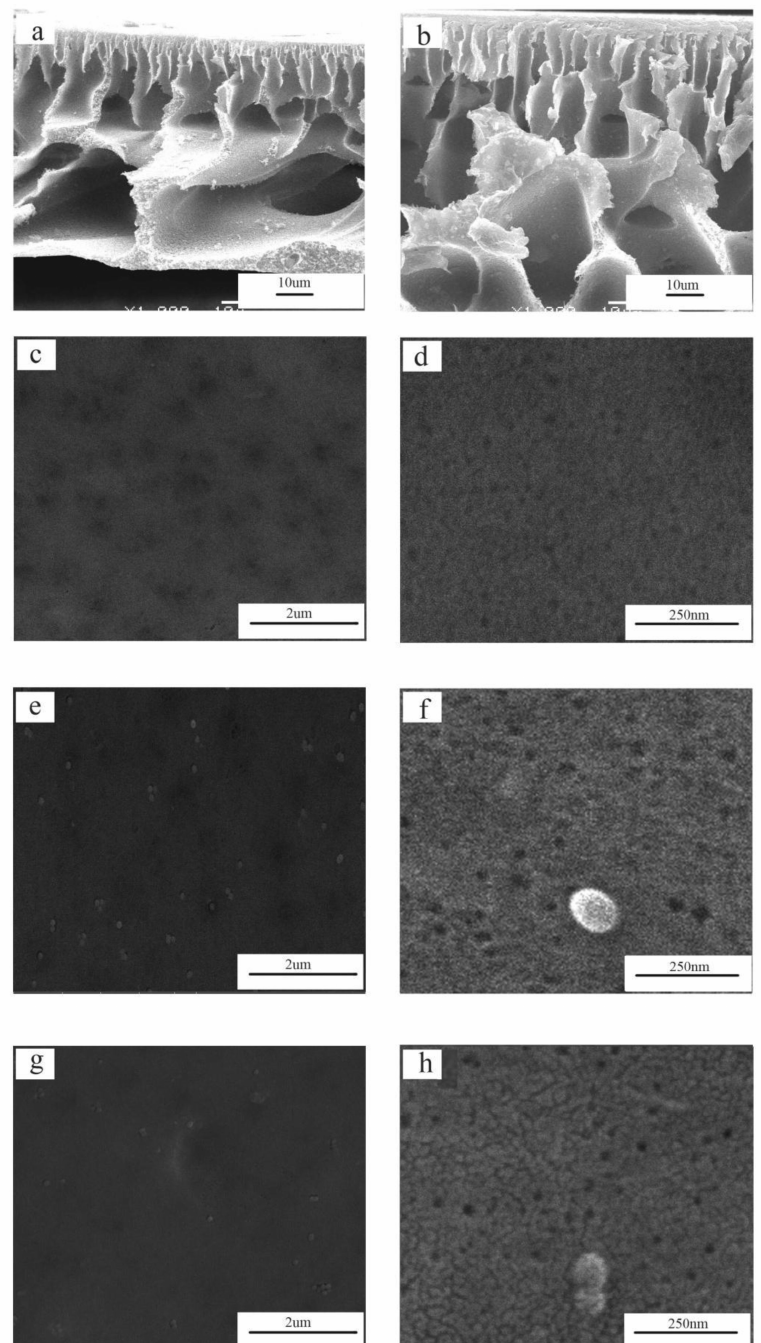
Figure 5. The cross-section morphologies of the PES ( a ) and PES/SiH1 ( b ) membranes; the surface morphologies of the PES ( c , d ), PES/SiH1 ( e , f ), and PES/SiH1/fP ( g , h )